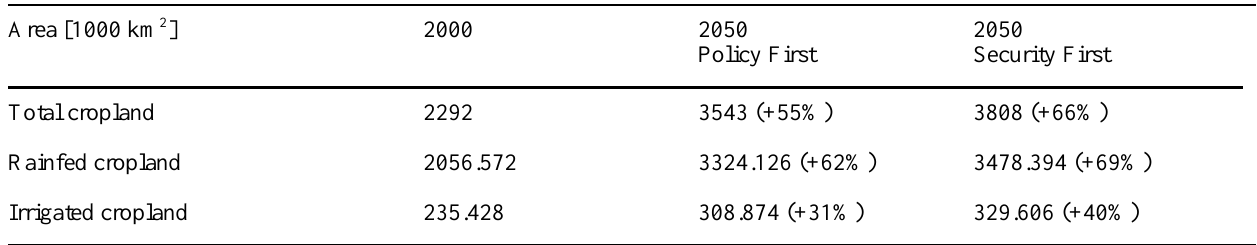
Table 1. Land-use data for the baseline and scenario